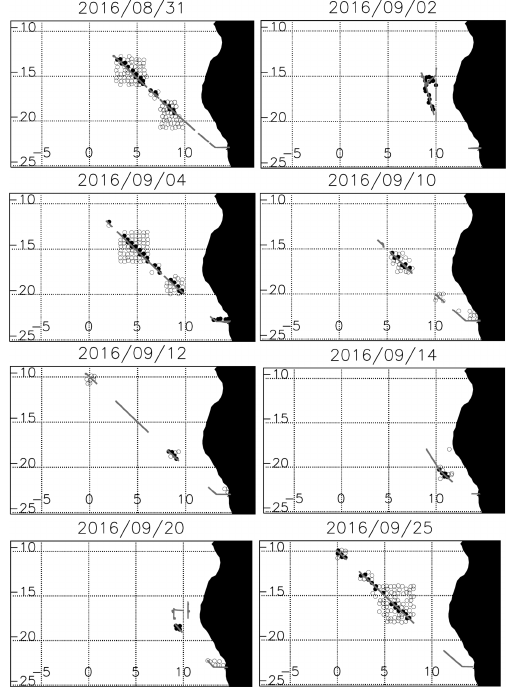
Figure 2. ORACLES aircraft profiles (thin grey line segments) over the southeastern Atlantic Ocean to the west of Africa are matched to AIRS fields of view (FOVs) with a loose spatial match (open circles) and tighter spatial match within 30km (closed circles) for eight flights in 2016.